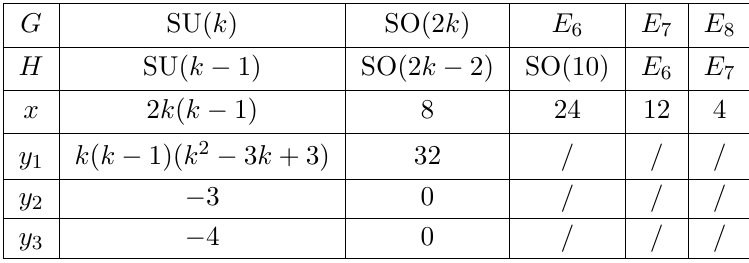
Table 3 . Curvature splitting constants for minimal embedding of U(1) into G